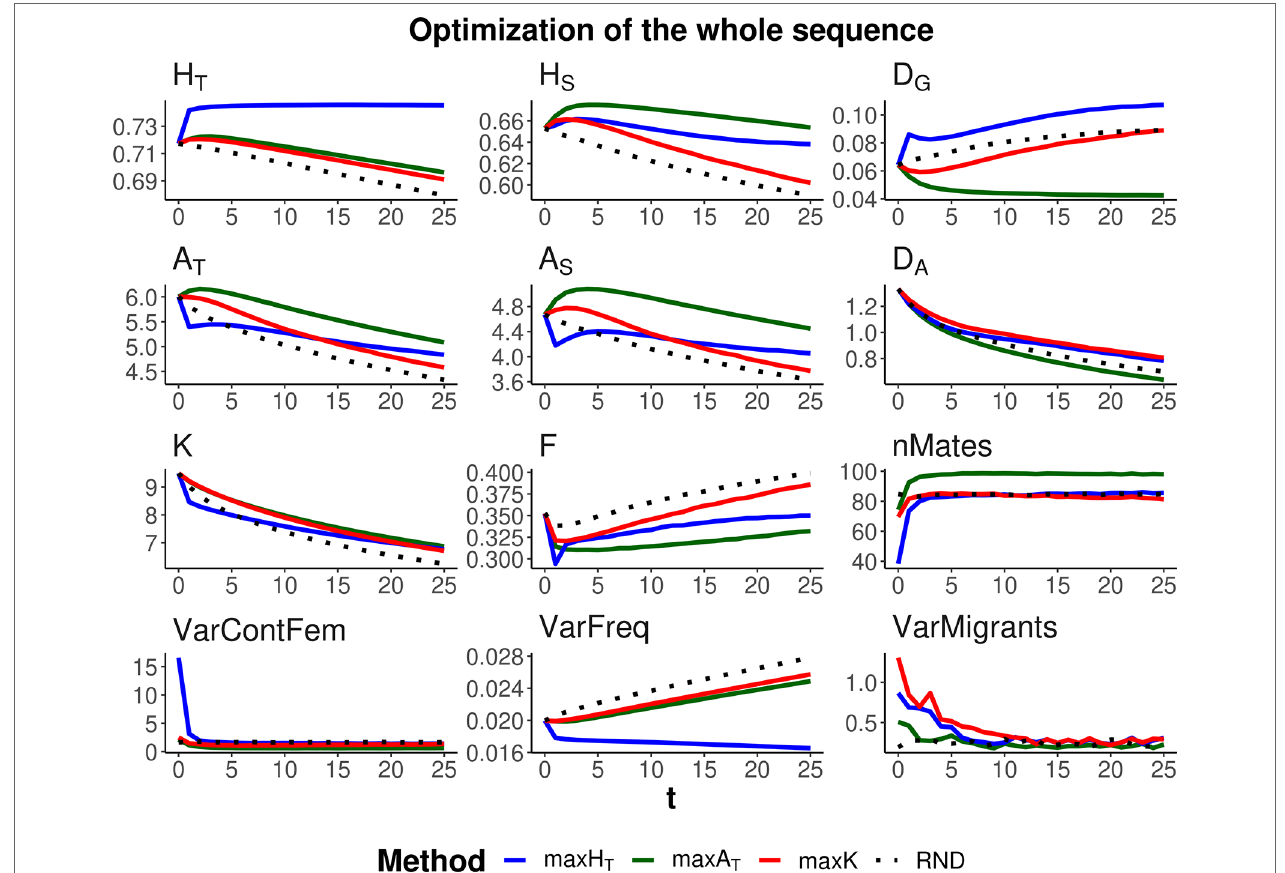
FIGURE 3 | Changes in different diversity parameters over generations ( t ) in a subdivided population subjected to three optimization methods, maxH T (blue line), maxA T (green line), and maxK (red line), and an unmanaged control (RND, dotted black line). Optimization was made for 120 multiallelic (single-nucleotide polymorphism haplotype) markers, but statistics were calculated for the whole simulated genome. Simulation characteristics and statistics as in Figure 2 . Standard errors for means are lower than 0.01 (allelic measures), 0.001 (heterozygosity measures), and 0.002 ( F